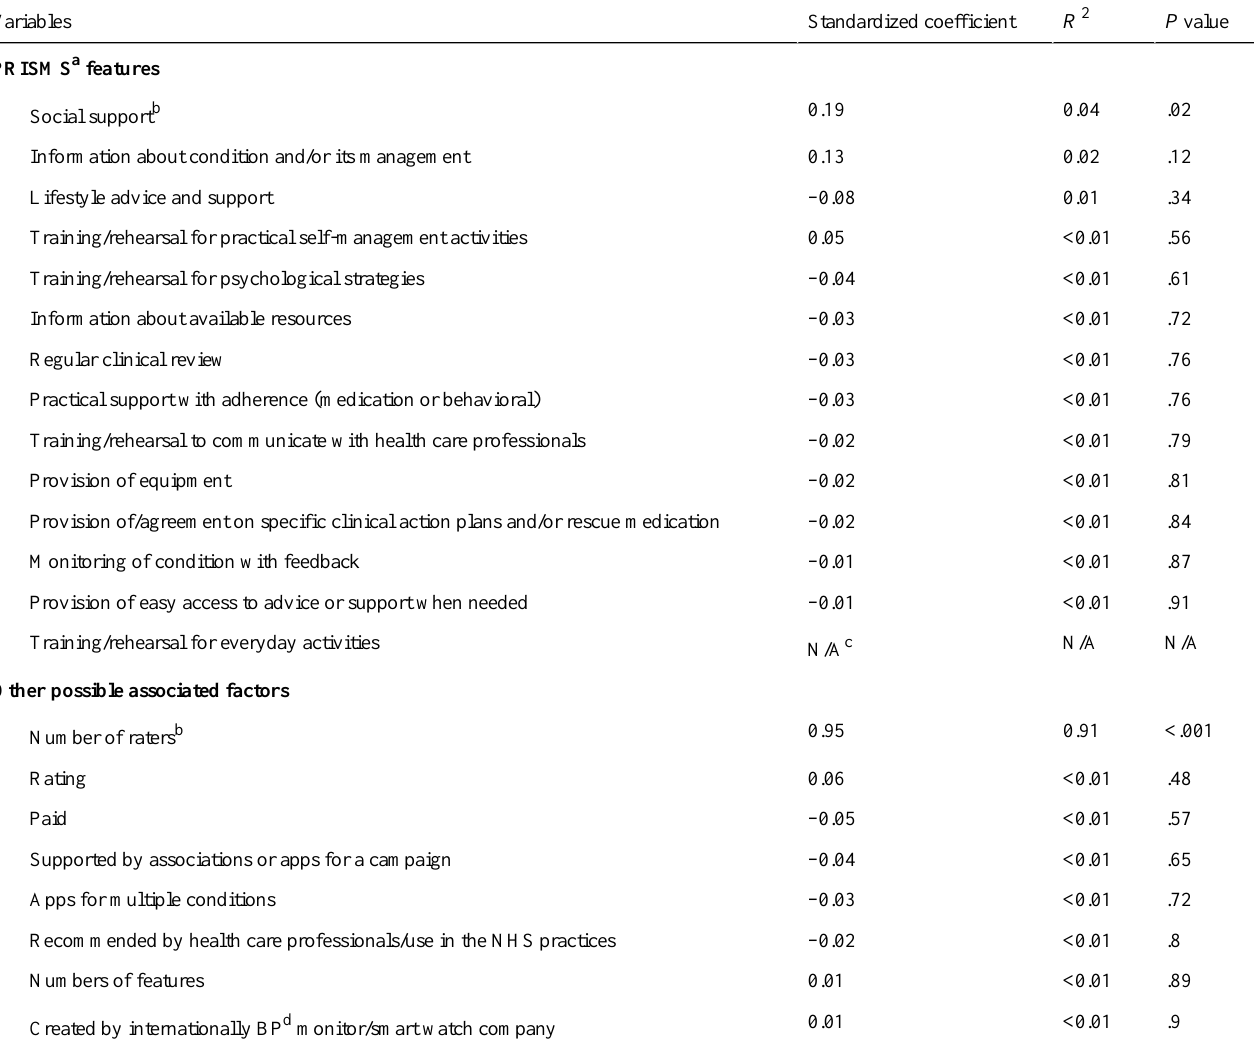
Table 2. R 2 and P values of a simple regression analysis at 5% significance level for downloads (Data were sorted by the P values in ascending